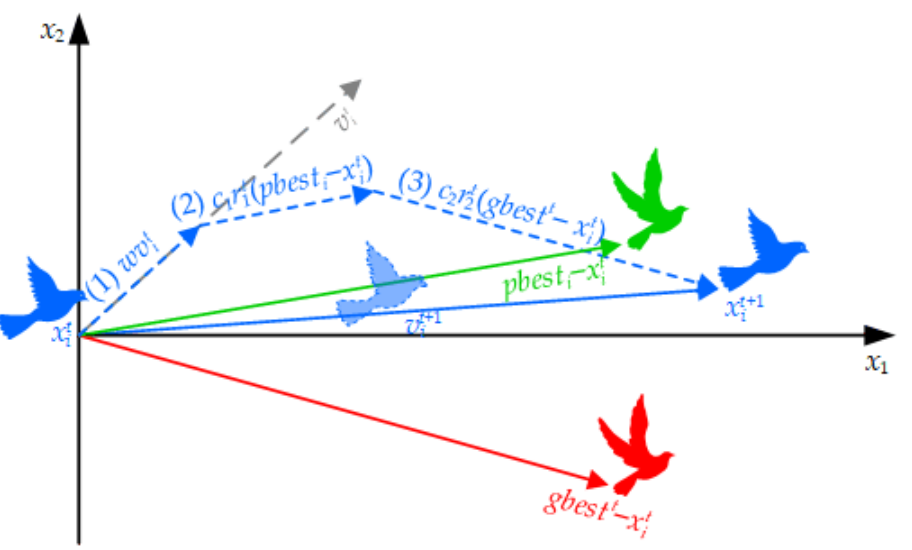
Figure 3. The update of velocity and position at t iteration regarding a bi-dimensional problem.